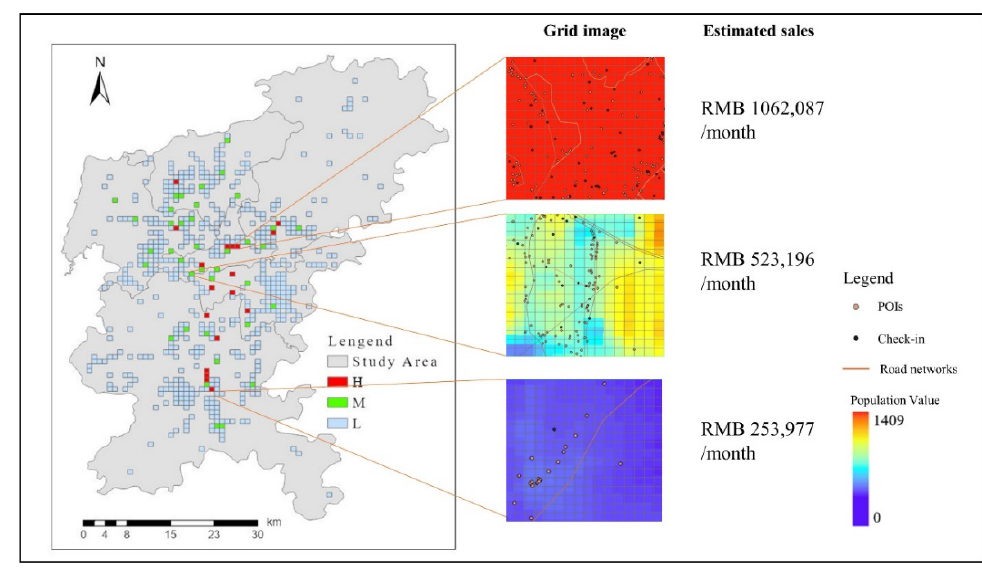
Figure 10. Results of market demand estimate. H: high market demand areas; M: medium market demand areas; L: low market demand areas.